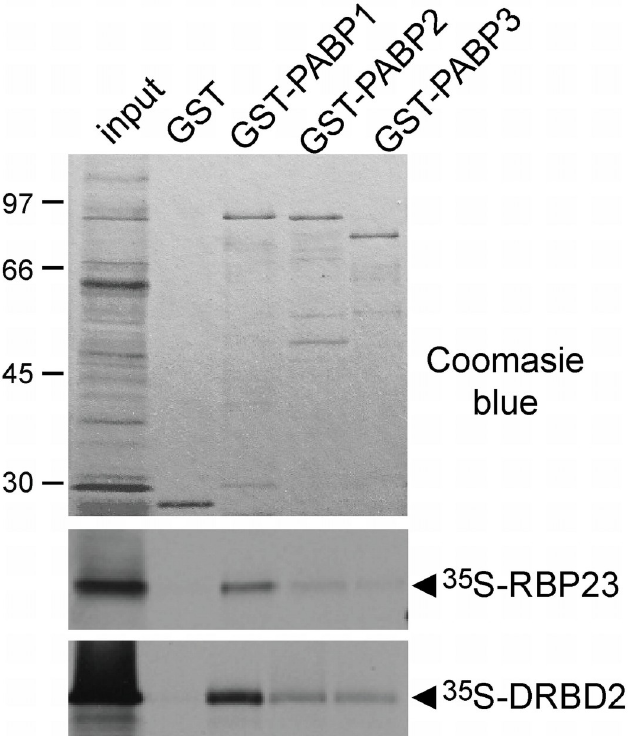
Fig 2. Protein-protein interaction assays investigating the direct binding between the L . infantum PABPs and their putative RBP23 and DRBD2 partners. Pull down assays between radiolabeled RBP23 or DRBD2 and three recombinant PABPs. The upper panel shows the Coomassie-blue stained gel indicating the radiolabeled protein input, the GST recombinant (negative control) and the GST-PABP homologues. The panels below are autoradiographs showing the result of the interactions between radiolabeled RBP23 or DRBD2 and recombinant proteins. The RBP23 and DRBD2 recombinant proteins are indicated by arrows.